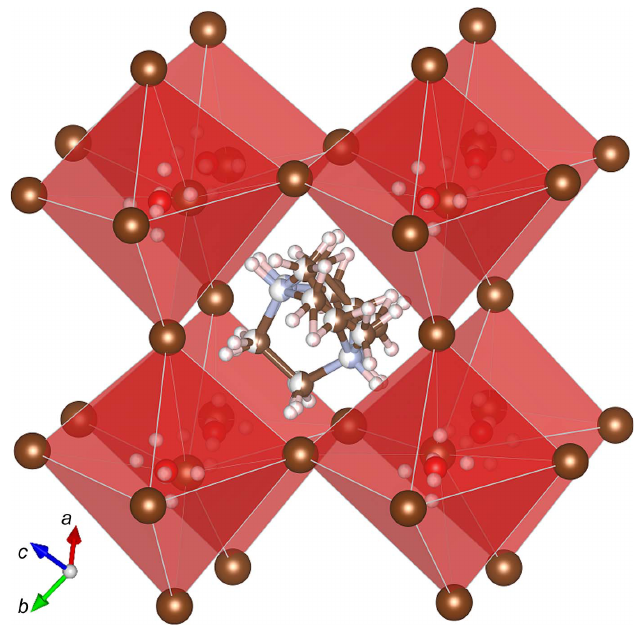
Figure 1 One pseudo-cubic subunit of the trigonal polymorph (cid:2) - [dabcoH 2 ] 2+ [H 3 O] + Br (cid:2) 3 , extracted from the 3D network of corner-sharing [H 3 O]Br 6 octahedra ( cf. Figs. S4, S5 and S6–S9). Colour and size code: large brown spheres Br, medium blue N, red O, medium brown C, small white H; two colours indicate the partial occupation of disordered N and C atoms.